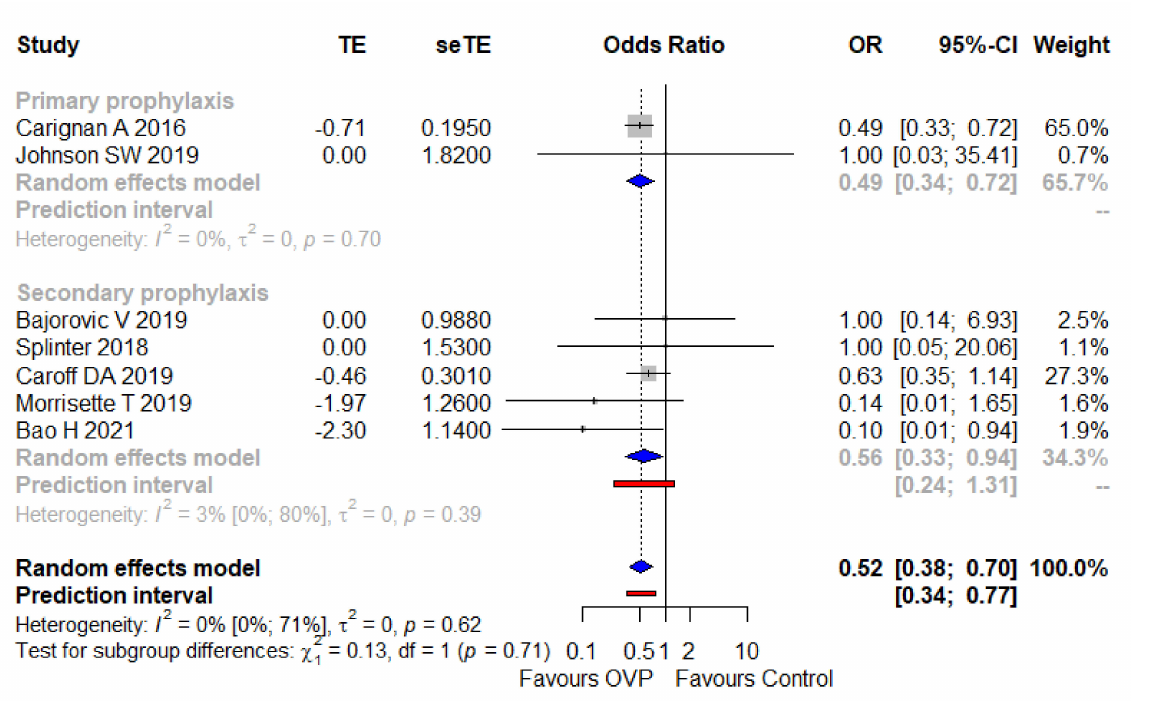
Figure 3. Meta-analysis regarding the adjusted odds ratio of CDI with OVP, overall and across the main subgroups. Abbreviations: CDI, Clostridioides difficile infection; OR, odds ratio; OVP, oral vancomycin prophylaxis; seTE, standard error treatment effect; TE, treatment effect; 95%-CI, confidence intervals at 95%. Vertical line indicates ‘no difference’ point between the two options. Squares represent adjusted odds ratios. Diamonds represent pooled adjusted odds ratios for all studies. Horizontal lines represent 95%